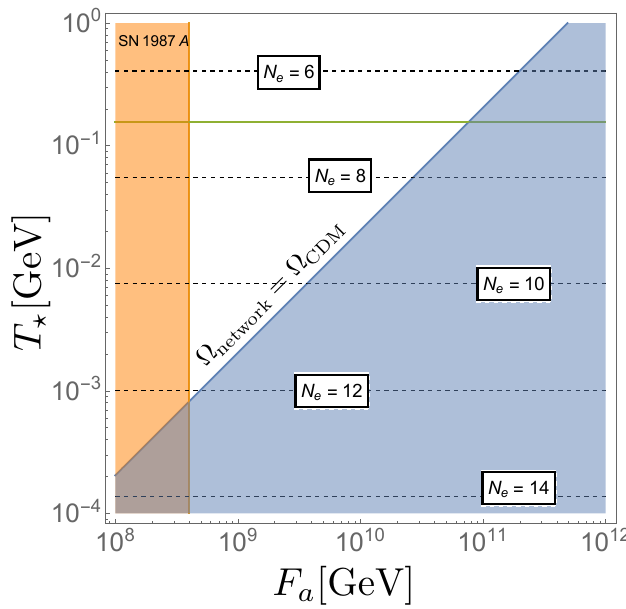
Figure 6 . Constraints on F a and T ? from DM overproduction from the late decay of the ax- ionic string-wall network. The solid blue line is obtained imposing (cid:10) network = (cid:10) CDM , according to eq. (4.14). The orange region is forbidden by astrophysical observations. The solid green line represent the critical temperature of the ordinary QCD phase transition after reheating. The dashed lines show the corresponding number of efolds of